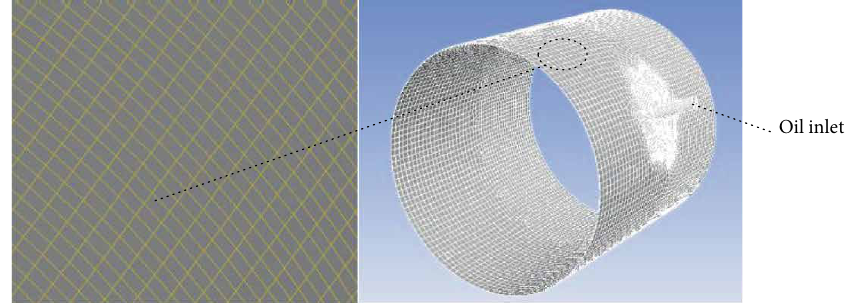
Figure 1: The structure of model and division of grid.